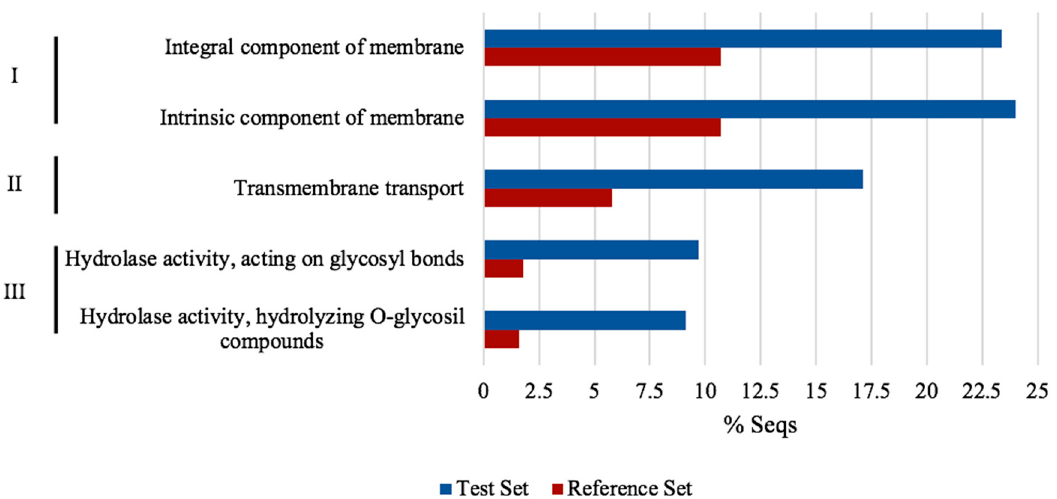
Figure 7. Differentially regulated genes gene ontology enrichment analysis of ∆ nrg1 strain. Graph shows enriched functional categories using whole differentially expressed genes (DEGs) by NRG1 in BLAST2GO with FDR ≤ 0.05. I, Cellular component; II, Biological process; III, Molecular function. The reference set were predicted genes in U. maydis genome and the test set were differential expressed genes obtained from Δ nrg1 transcriptome at pH 4.